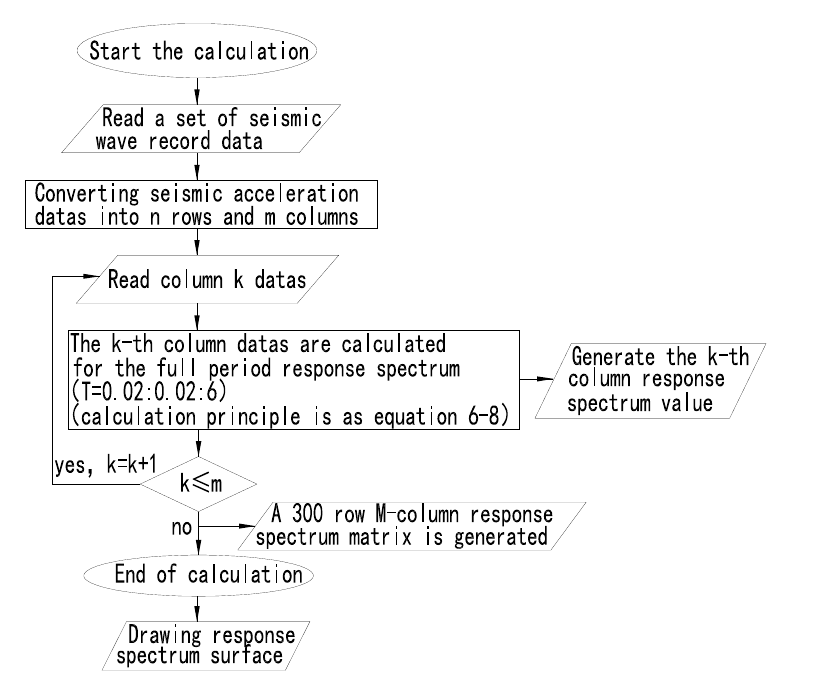
Figure 4. Flow chart for generating the time-domain seismic response spectral matrix.